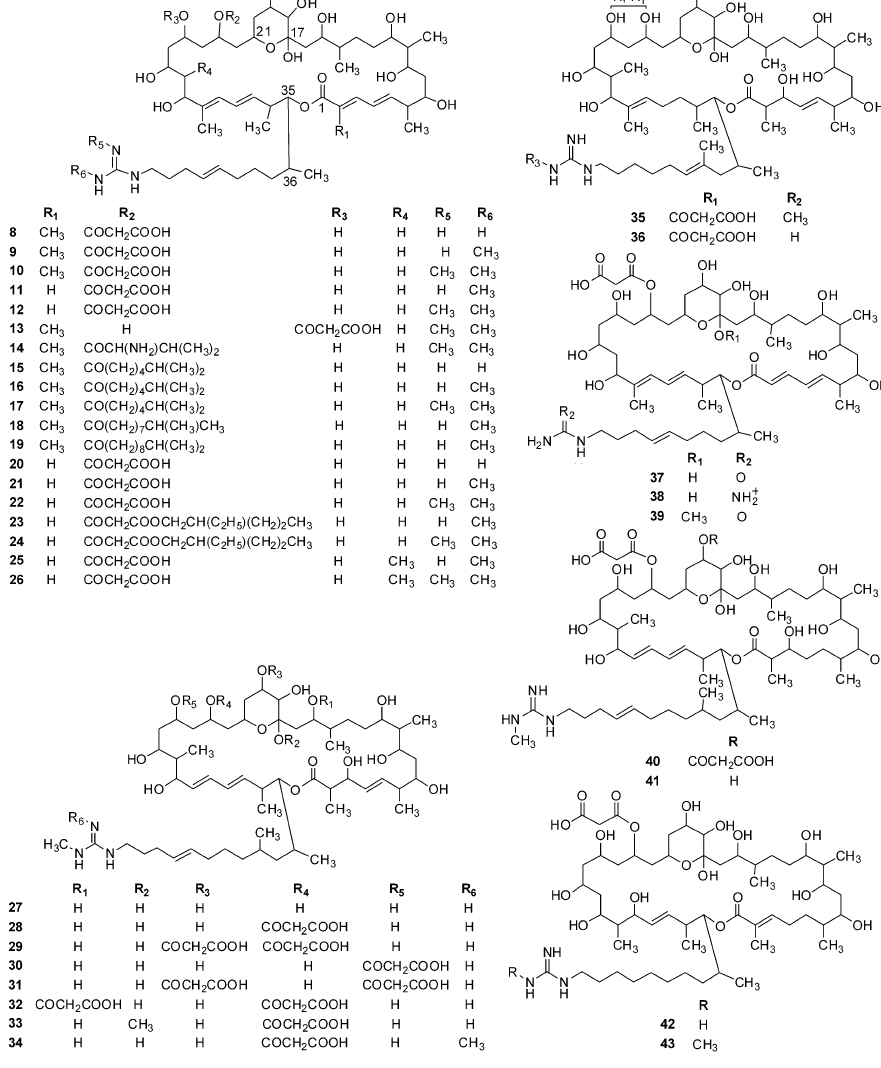
Figure 2. Chemical structures of 36-membered guanidine-containing polyhydroxyl macrolides ( 8 – 43 ).